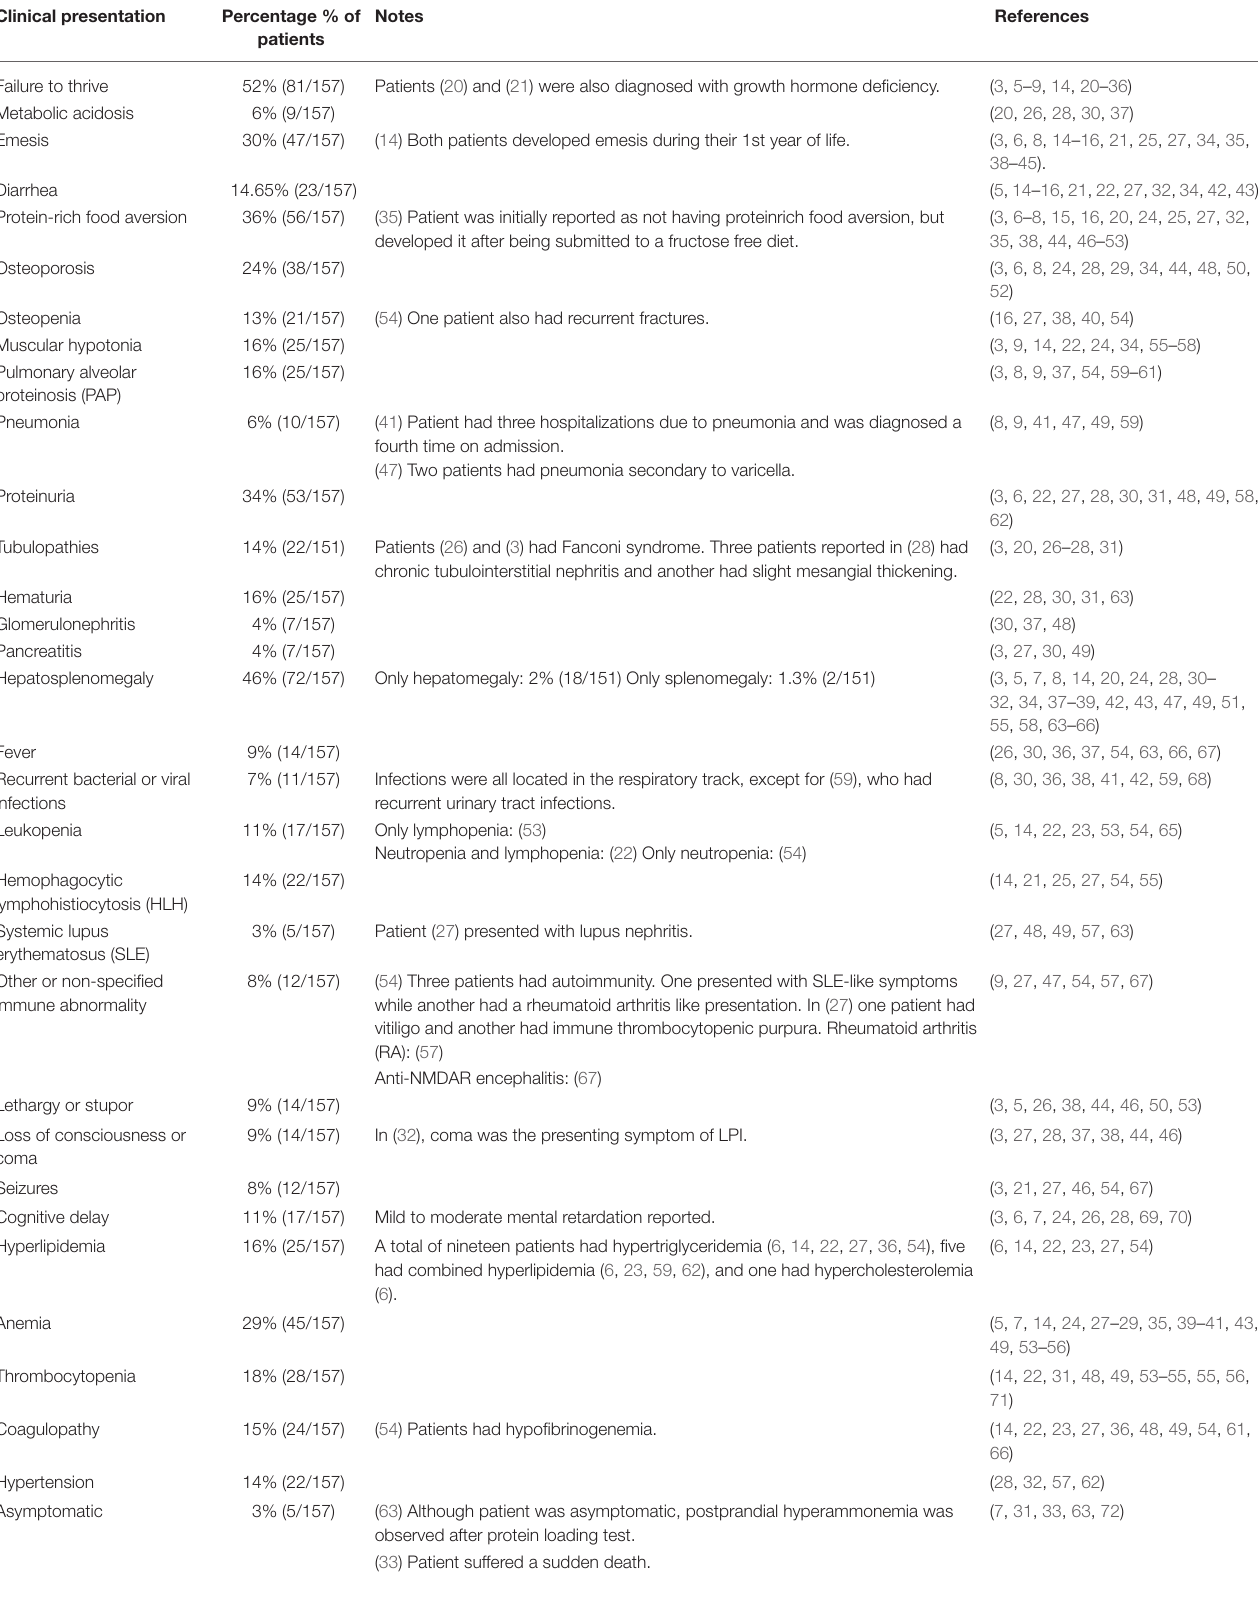
TABLE 3 | Clinical presentation of published LPI